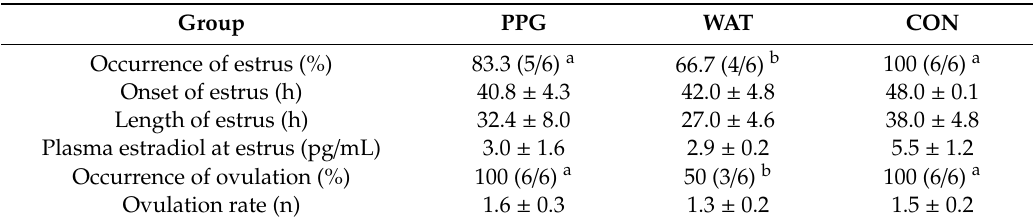
Table 1. Percentage and timing of occurrence of estrus behavior, estradiol concentration at estrus, and occurrence and number of ovulations in ewes treated with two doses PGF 2 α and a single dose of distilled water (CON) or 50 µ g of GnRH in either i.m. distilled water (WAT) or s.c. propylene-glycol (PPG) at 32 h after the second PGF 2 α dose.